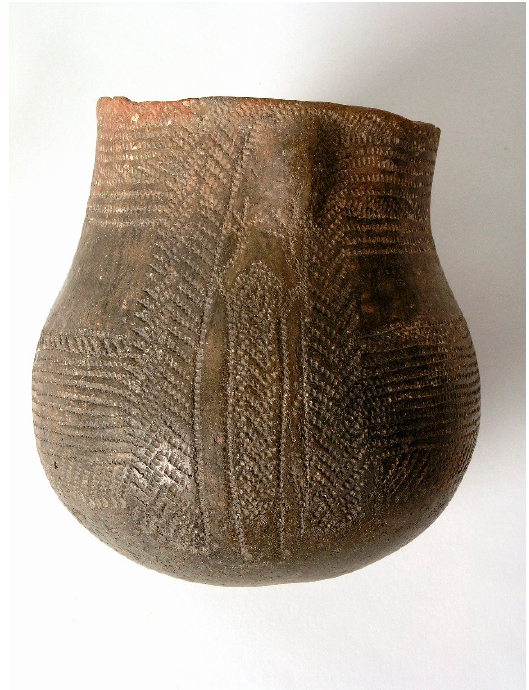
Figure 1. Prayer glass. 5th–4th millennium BC Cova de l’Or. Museum of Alcoi.